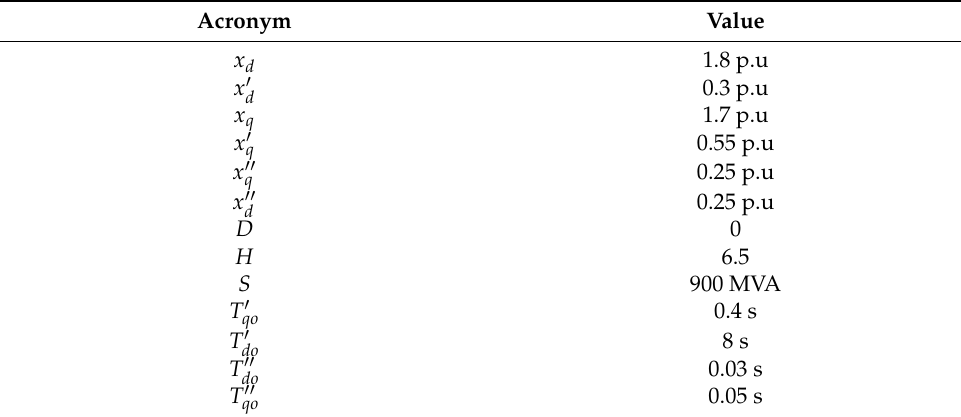
Table A1. Synchronous generator parameters